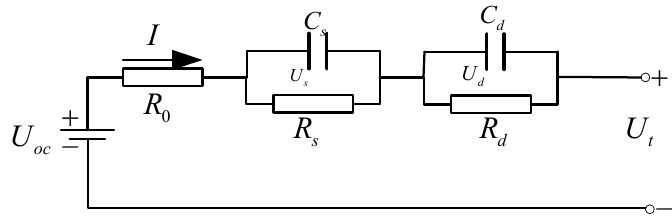
Figure 1. Schematic diagram of the two-order resistor–capacitor (R-C) model. R 0